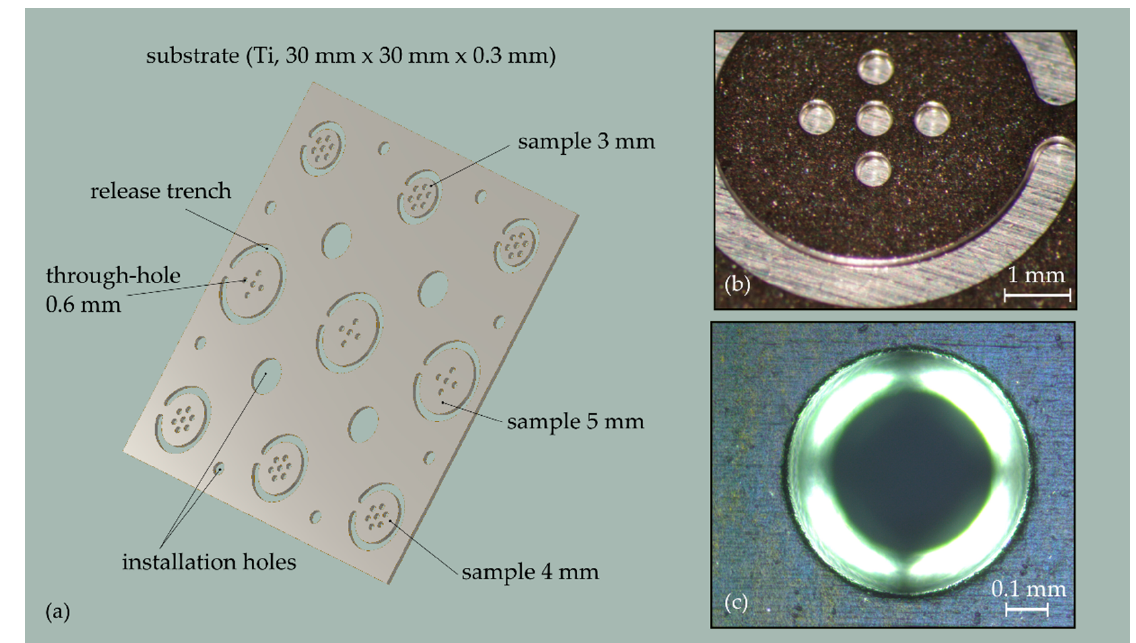
Figure 3. ( a ) CAD drawing of the substrate specifically designed for the development of the dia- phragm fabrication process; ( b ) optical microscope image of one of the nine samples on a substrate containing five through − holes; ( c ) microscope image showing the etch profile of a 0.6 mm large through − hole.